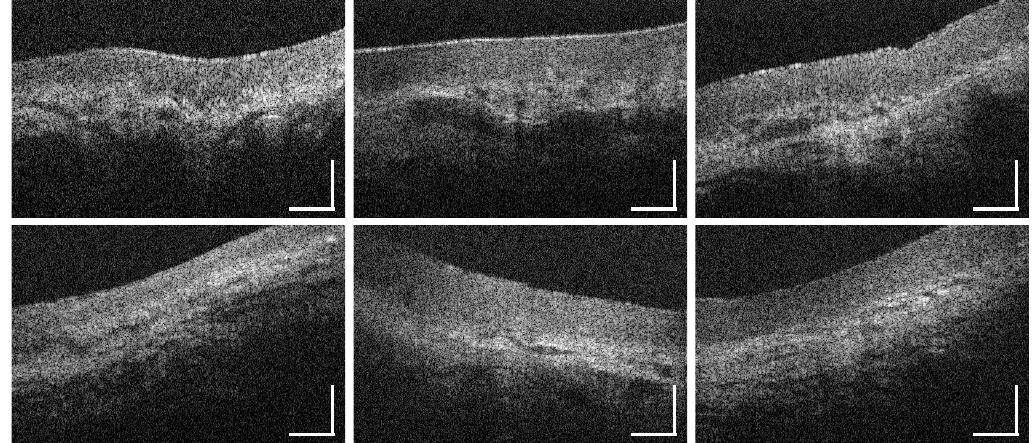
Figure A12. Supplementary intensity-based OCT cross sections of the alveolar mucosa of the upper vestibular region (MP2, Figure 1). Scale bars: 200 µ m.